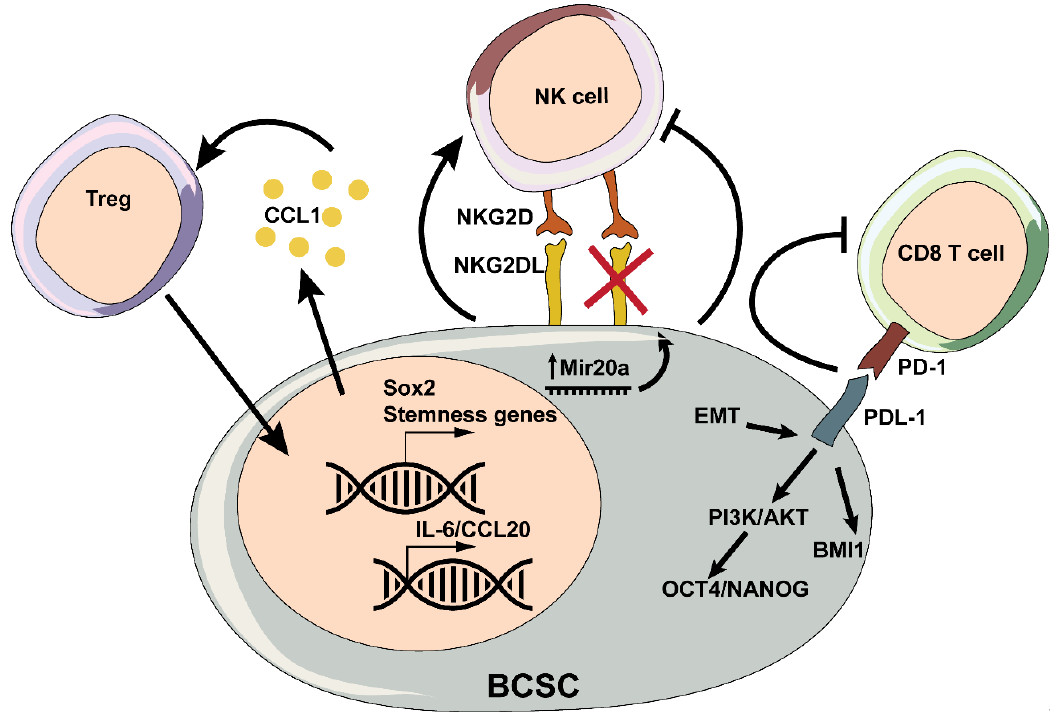
Figure 2. Schematic representation of interactions between T cells, natural killer (NK) cells and BCSCs.